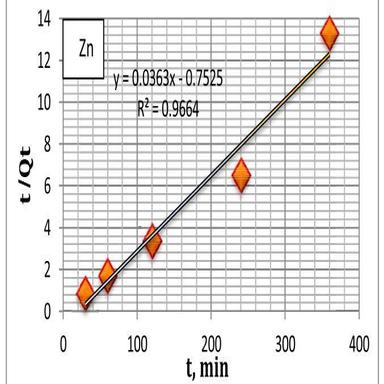
Plot of pseudo-second order reaction for adsorption of heavy metals by SiO2@C nanocomposite (SC1).